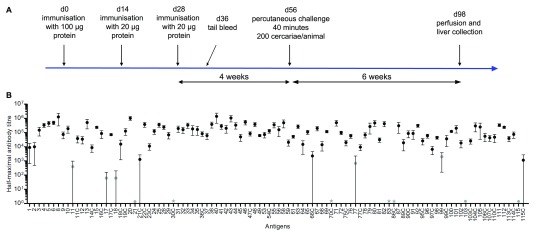
Recombinant cell-surface and secreted
Schistosoma mansoni antigens raised robust immune responses in mice.(
A) Experimental timeline detailing the immunisation regime, blood sampling, percutaneous infection and sample collection followed for each group of immunised animals. (
B) The average half-maximal antibody titres of mice immunised with individual antigens are shown. The suffix C indicates the presence of a C-terminal rat Cd4d3+4 tag in the antigen tested. Protein numbering corresponds to that presented in Table 1. Antigens that were initially tested without a Cd4 tag and induced half-maximal titres <1:10,000 are shown as grey circles. Four antigens (proteins 30C, 70C, 83 and 86C) did not induce any humoral response and are indicated by grey stars. Datapoints represent mean ± SD;
n = 5 or more animals per group, with the exception of proteins 13, 18C, 28 and 42 (
n = 4), and protein 17C (
n = 3) due to premature mortality.